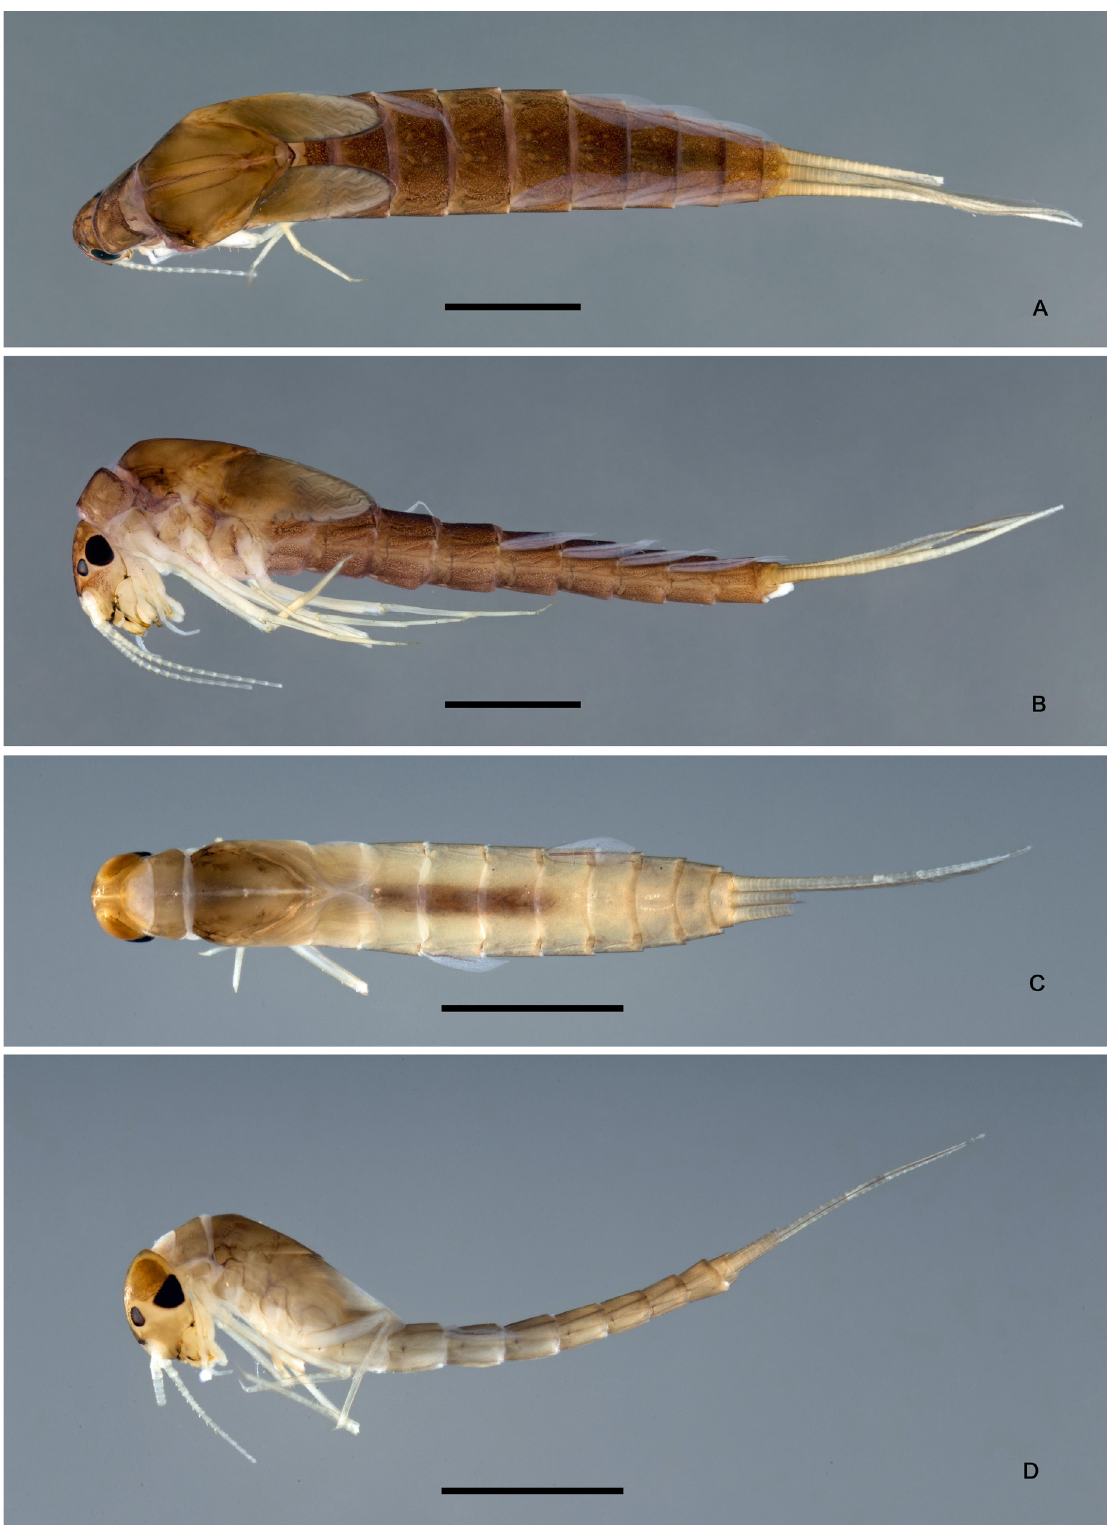
Fig. 12. Habitus, larvae. A . Procerobaetis leptobranchius gen. et sp. nov., dorsal view. B . P. leptobranchius gen. et sp. nov., lateral view. C . P. petersorum gen. et sp. nov., dorsal view. D . P. petersorum gen. et sp. nov., lateral view. Scale bars: 1